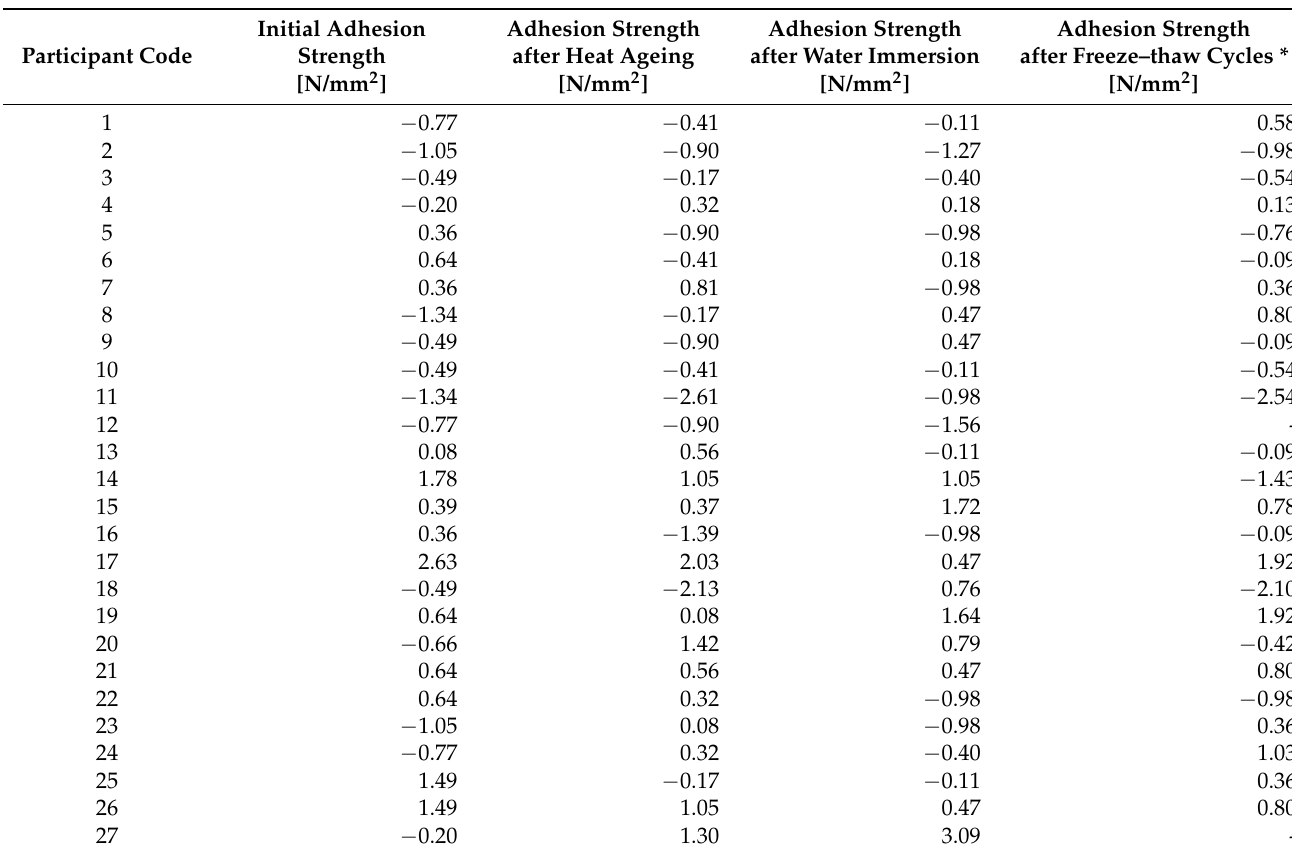
Table 6. The z-score values calculated for each participating laboratory for measurements of CTA initial tensile adhesion strength, tensile adhesion strength after heat ageing, tensile adhesion strength after water immersion, and tensile adhesion strength after freeze–thaw